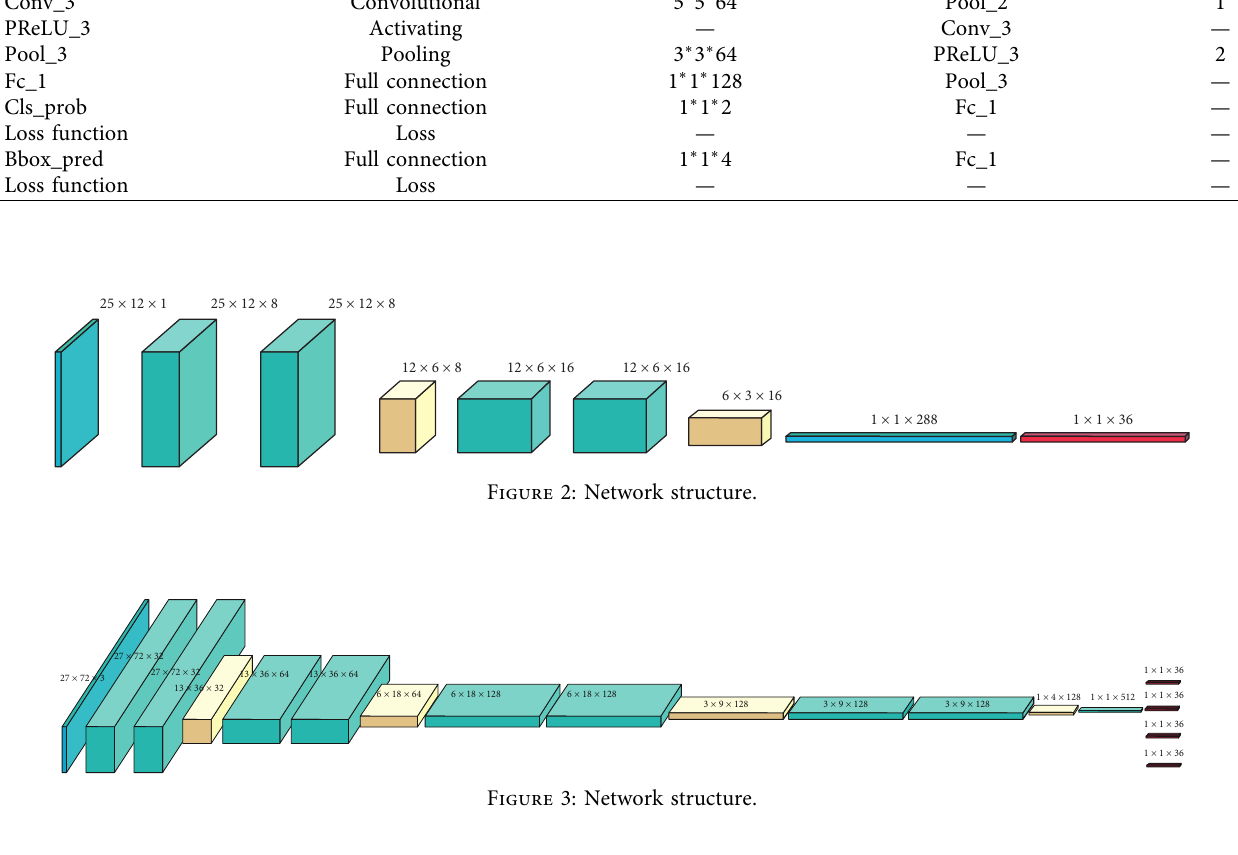
Figure 3: Network